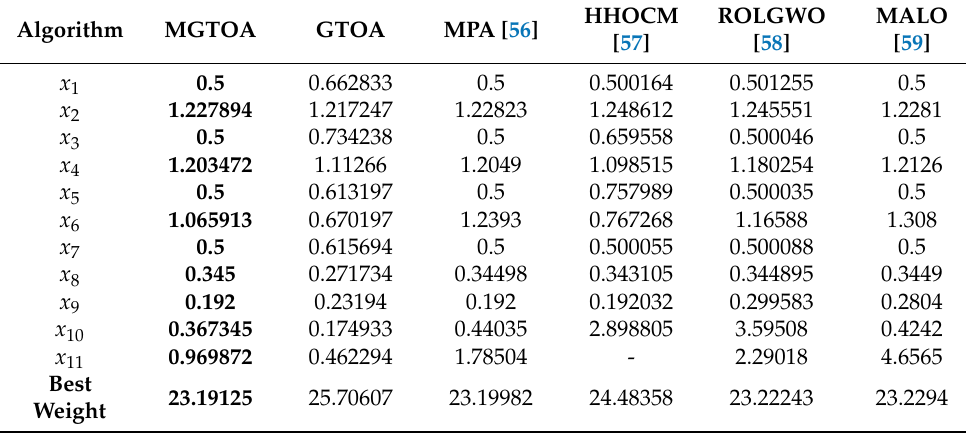
Table 14. Experimental results of Car Crashworthiness Design.